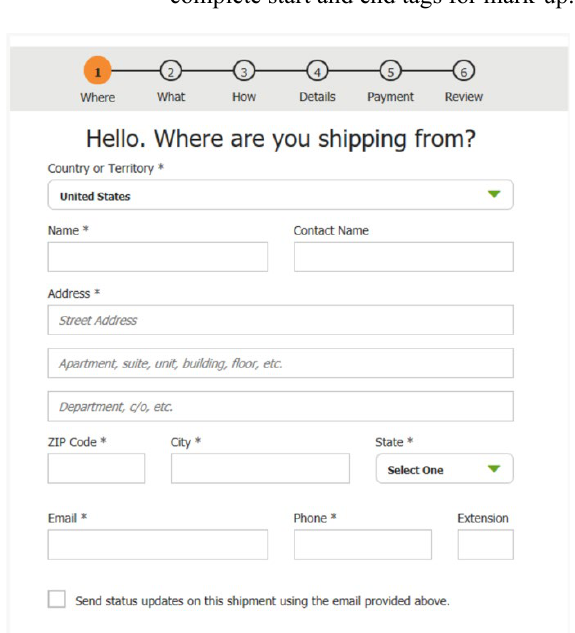
Figure 3. Example of using an asterisk to indicate required fields. Source